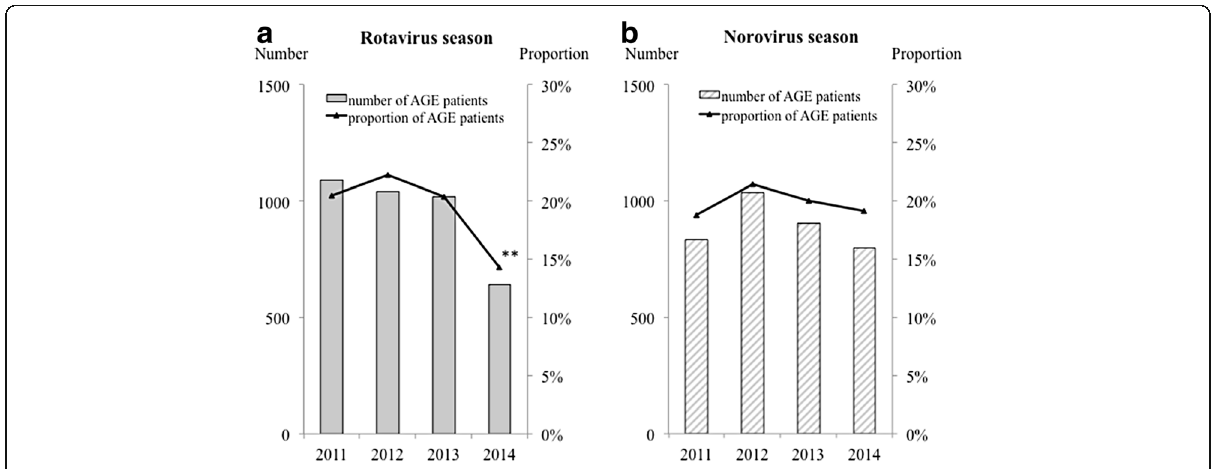
Fig. 3 Numbers and proportions of AGE patients ≤ 2 years of age in the a rotavirus and b norovirus epidemic seasons. Gray columns and gray stripe columns indicate the numbers of AGE patients ≤ 2 years of age in the rotavirus season and norovirus season each year, respectively. The line indicates the proportions of AGE patients based on the total numbers of visiting patients. ** p <0.01 compared with in 2011. AGE, acute